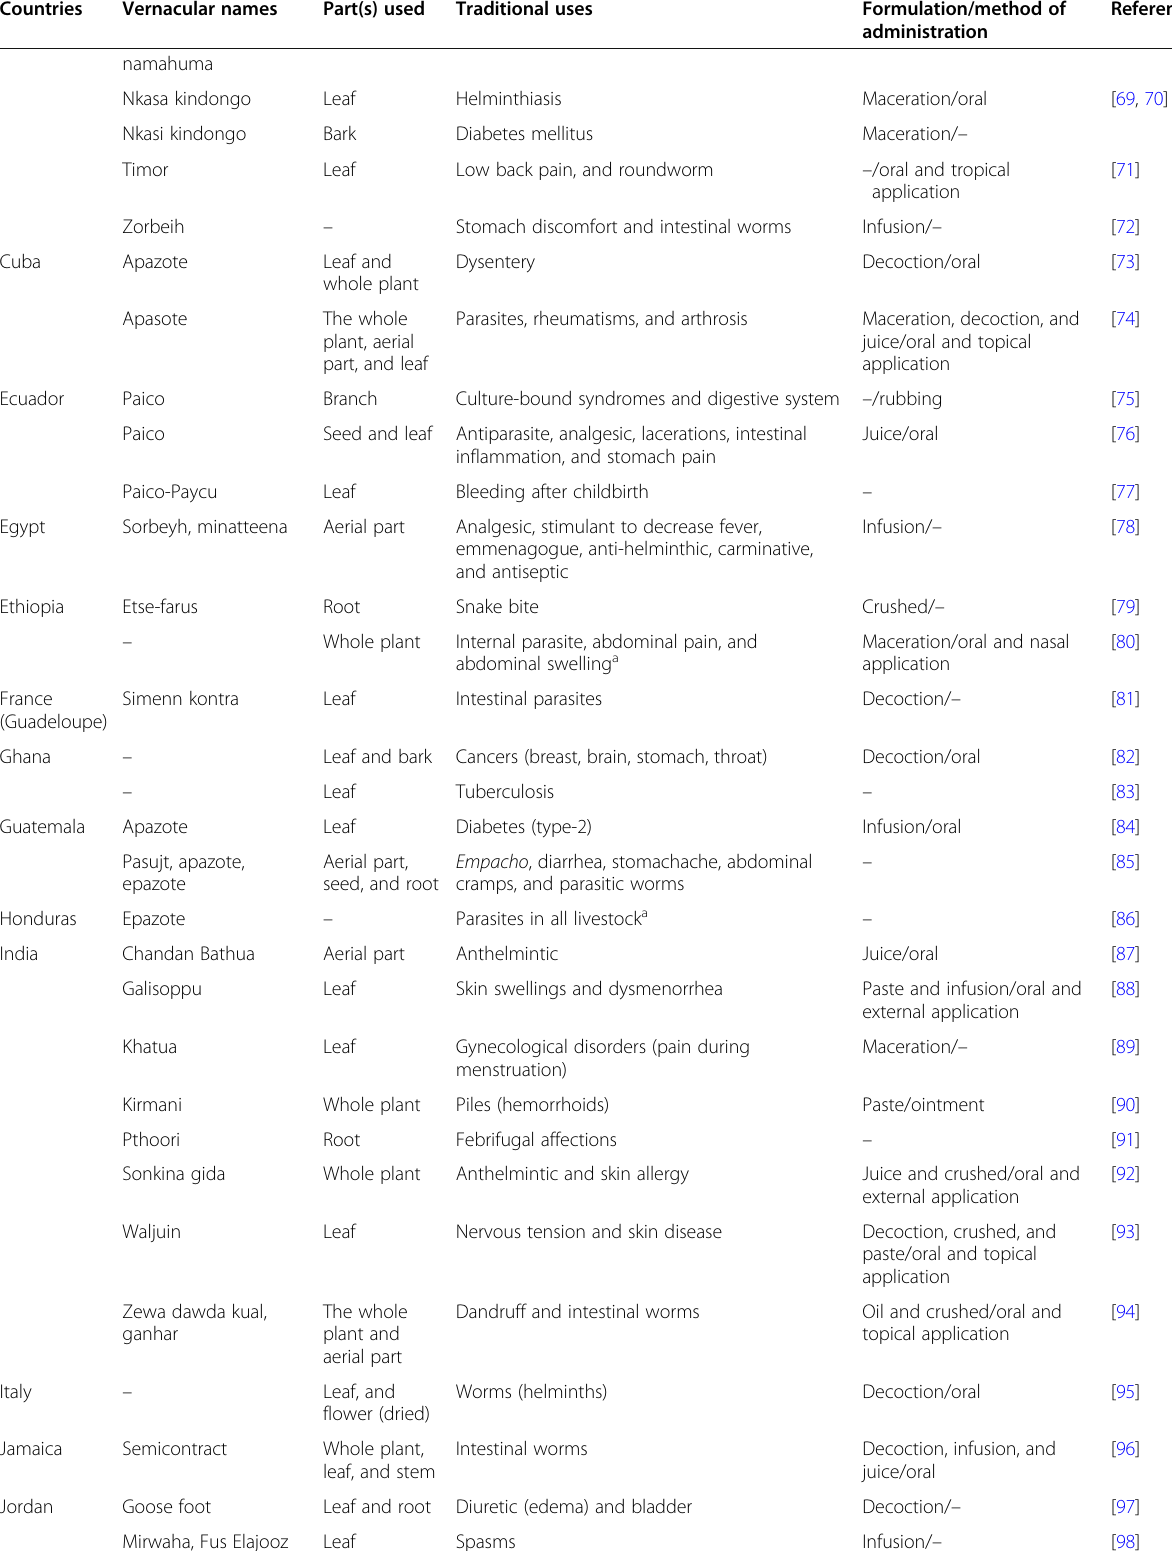
Table 1 Traditional uses of the different parts of C. ambrosioides worldwide (Continued)